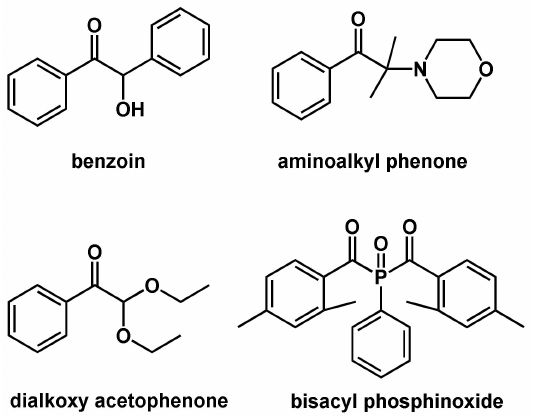
Figure 7. Chemical structures of common type I photoinitiators.